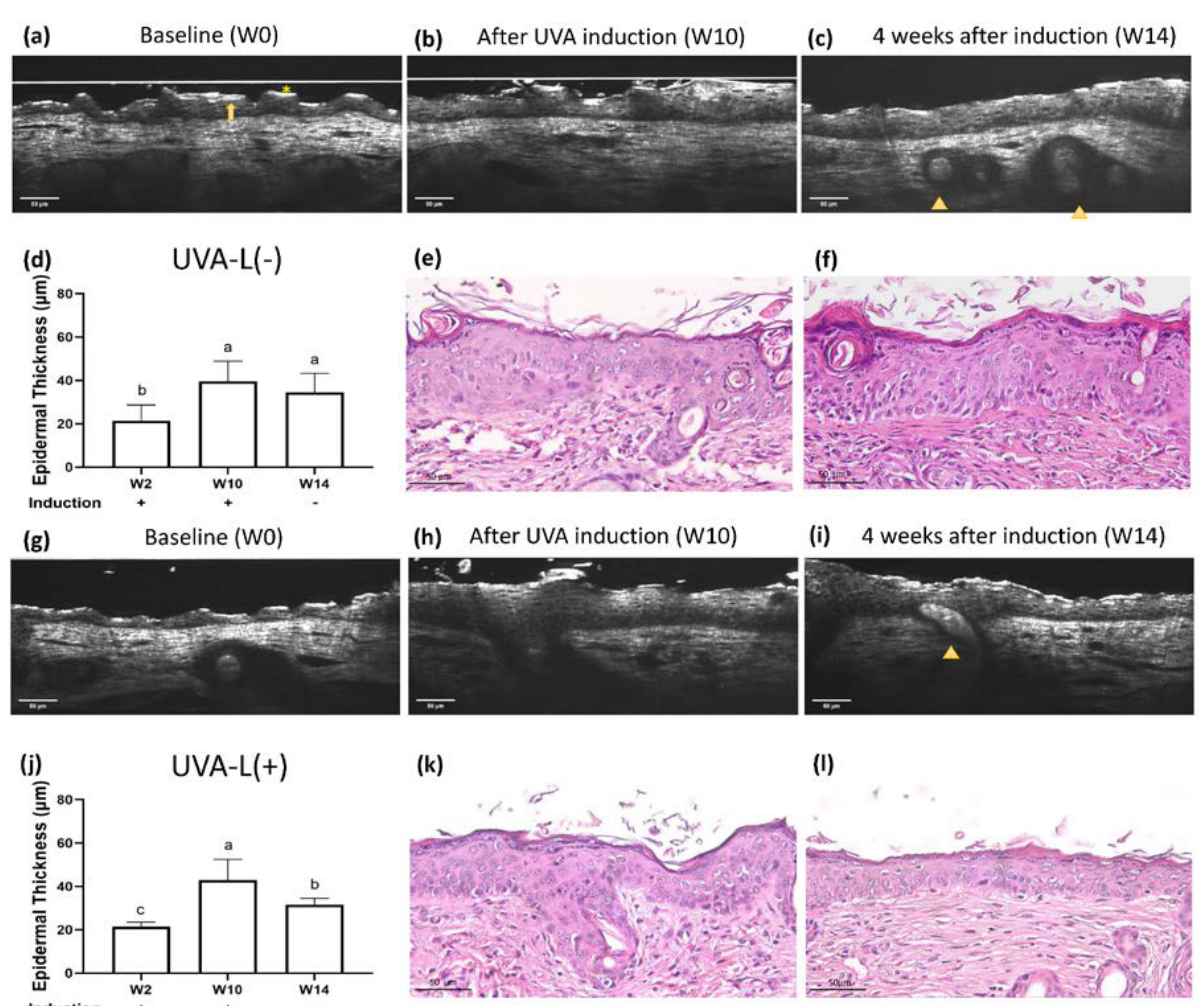
Figure 2. Real-time optical coherence tomography (OCT) and histology images of UVA-L( − ) nude mice at ( a ) baseline (W2), ( b ) complete UVA induction (W10), and ( c ) 4 weeks after spontaneous recovery (W14). The UVA-L(+) group received laser immediately after UVA induction. Real-time OCT images of UVA-L(+) nude mice at ( g ) W2, ( h ) W10, and ( i ) W14. Nude mice have a defective stratum corneum, which appears as an irregular and discontinuous thin uppermost hyperreflective layer (*). It is sometimes followed by a lower gray zone and a thin layer of hyperreflective stratum granulosum, together contributing to the “sandwich sign” (arrow). Abortive hair bulbs are embedded in the hypodermis (arrowhead). ( e , k ) After UVA irradiation, perinuclear vacuoles in keratinocytes, mild intercellular edema, and epidermal acanthosis were observed. In the dermis, endothelial cells were enlarged, and the perivascular infiltration with mast cells, neutrophils, and lymphocytes was prominent. Epidermal thickness changes in two groups, shown in ( d , j ). Different letters indicate statistically significant differences ( p < 0.05). The UVA-L(+) group showed better recovery from epidermal thickening than the UVA-L( − ) group. ( f , l ) The laser group ( l ) demonstrated lesser epidermal acanthosis and decreased perivascular inflammatory cells infiltration compared to the nonlasered group ( f ).